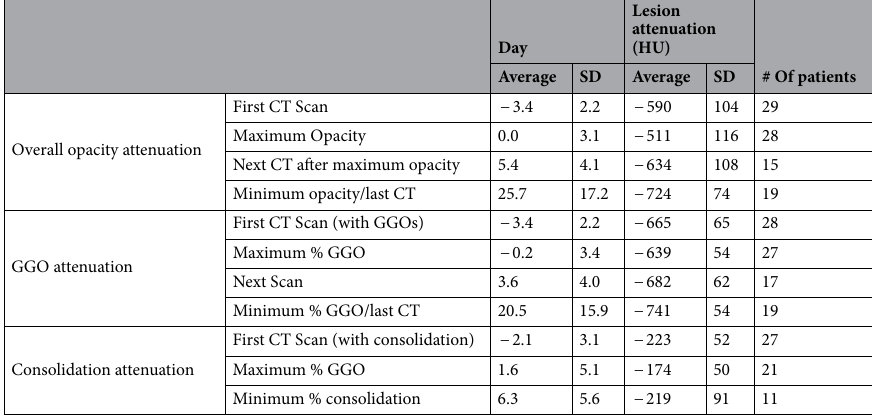
Table 2. Data used to generate the dynamic curves for COVID-19 lesion